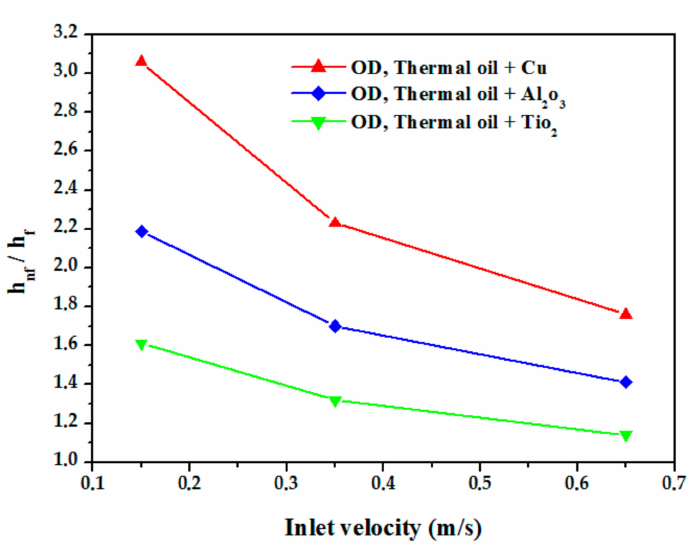
Figure 16. Axial evolution of nanofluid temperature for inlet velocity ( v = 0.35 m/s).